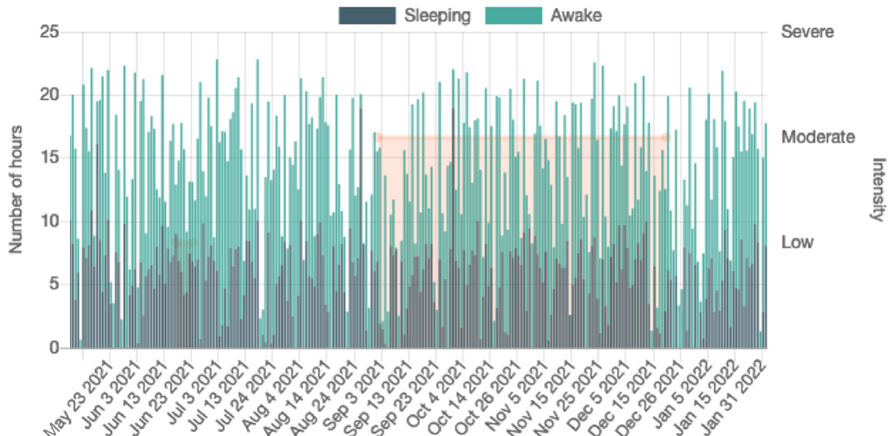
Figure 4. Visualization of the sleeping diary, thus the intervals during which a user was asleep or awake, along with one moderate relapse shown in the orange opaque box.